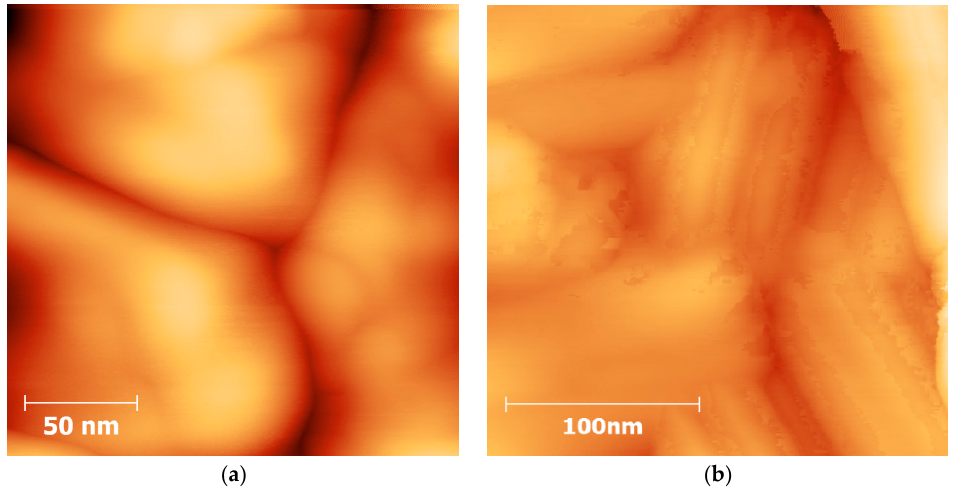
Figure 4. High resolution AFM topography images acquired at 303 K ( a ) on the fresh sample and ( b ) after eight thermal cycles. Images were recorded at 512 × 512 pixels at a line rate of 2 Hz. The scan size was ( a ) 200 × 200 nm 2 and ( b ) 220 × 220 nm 2 .